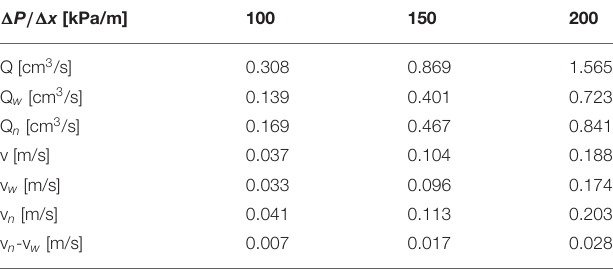
TABLE 3 | Volumetric flow rates Q and fluid velocities v for case (A) and three different settings of the pressure drop across the network.